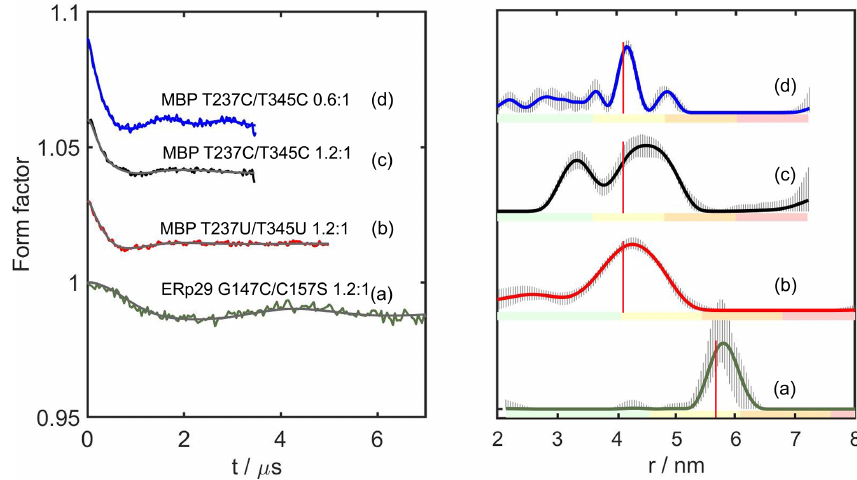
Figure 4. DEER distance measurements with DCP-( L -Cys) 2 -Gd tags. The left panel shows the form factors after background correction, where the vertical axis plots the normalised echo intensity and the red line corresponds to the fitted trace using the distance distribution calculated by DeerAnalysis2022 (Jeschke et al., 2006) and displayed in the right panel. The corresponding distance distributions predicted with the program PyParaTools (Stanton-Cook et al., 2014) are shown in Fig. S14. The data are annotated with the names of the proteins and the molar ratios of Gd 3 + ions to DCP-Cys 2 tagging sites. (a) ERp29 G147C/C157S with a metal-to-tag ratio of 1 . 2 : 1. (b) MBP T237U/T345U with a metal-to-tag ratio of 1 . 2 : 1. (c) MBP T237C/T345C with a metal to tag ratio of 1 . 2 : 1. (d) Same as (c) but with a metal to tag ratio of 0 . 6 : 1. The vertical red lines indicate the maxima of the modelled distance distributions. The colour bar underneath the distance distributions indicates the reliability regions as defined in DeerAnalysis and determined by the DEER evolution time (green – the shape of the distance distribution is reliable; yellow – the mean distance and distribution width are reliable; orange – the mean distance is reliable; red – unreliable long-range distances). The solid lines represent the distributions with the smallest root mean square deviation in relation to the experimental data. The striped regions indicate the range of alternative distributions ( ± 2 times the standard deviation). The primary DEER data are shown in Fig. S9, and the distance analysis by DeerNet (Worswick et al., 2018) is given in Fig. S10.